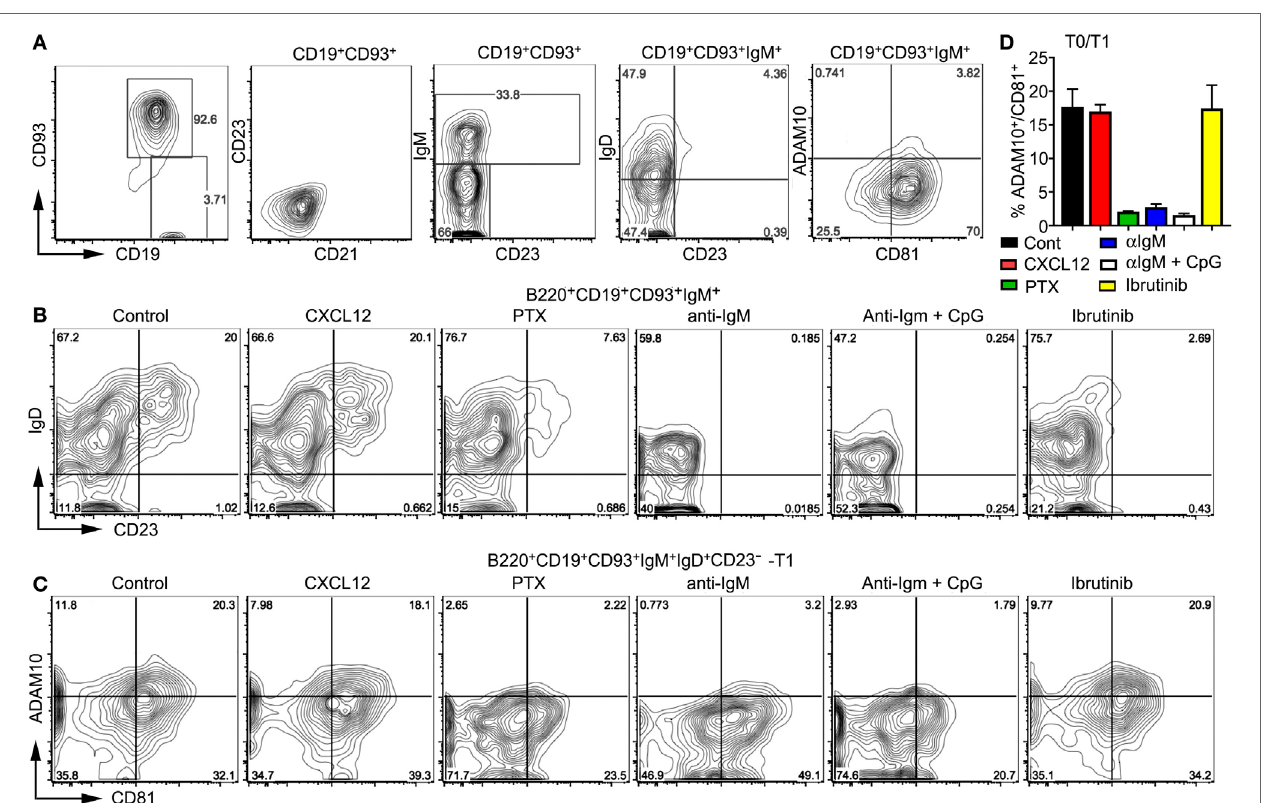
FigUre 7 | Gi signaling raises ADAM10 expression on transitional B cells. (a) Characterization of the bone marrow-derived progenitor B cells prior to their addition to OP9-DL1 cultures. Mouse bone marrow cells were cultured with IL-7 for 4 days after which the non-adherent cells were removed. The collected cells were characterized by flow cytometry as indicated. (B,c) Flow cytometry results of OP9-Delta-like 1 (DL1) cultures of bone marrow-derived B cells treated with pertussis toxin (PTX), CXCL12, anti-IgM, anti-IgM + CpGs, or Ibrutinib. Before transferring on to OP9-DL1 cells, some developing B cells were treated with PTX (200 ng/ml) for 2 h. On day 0 and day 1 after transfer to the OP9-DL1 cells, CXCL12 (200 ng/ml), anti-IgM (10 µg/ml), CpGs (1 µg/ml), or Ibrutinib (30 nM) were added. On day 2, the non-adherent cells were immunostained and analyzed by flow cytometry to assess IgD versus CD23 expression (B) or ADAM10 versus CD81 (c) on the cells gated as indicated. Comparable results were observed in two other experiments. (D) Chart showing % of ADAM10 + CD81 + cells in OP9-DL1 cultures of WT bone marrow cells treated as in panel (B) . Analysis of transitional B cell type 0 (T0) and T1 cells 2 days after plating on OP9-DL1 cells. Data are from two independent experiments and are the mean ± SEM (* p < 0.05, ** p <